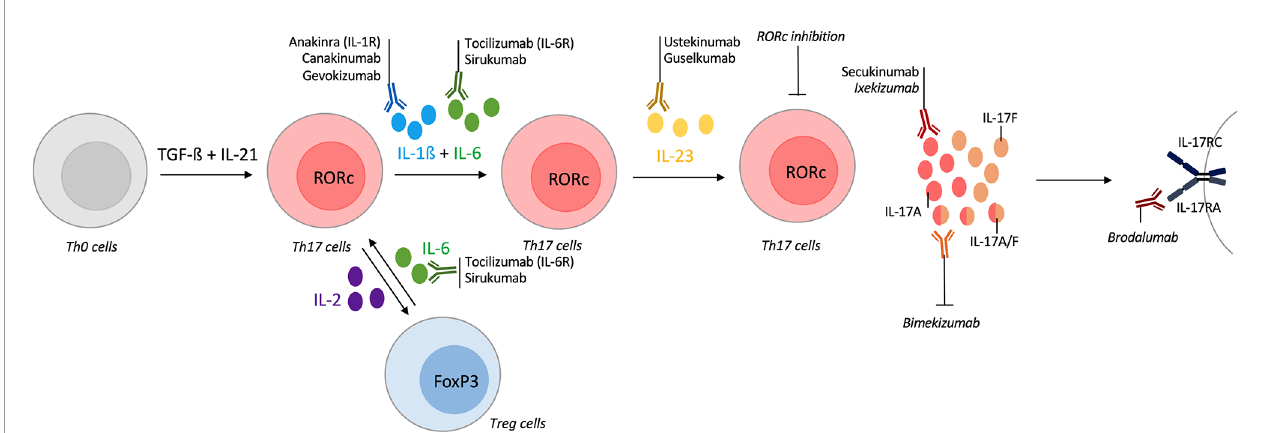
FIGURE 4 | Tools for targeting the IL-17/Th17 pathway in vasculitis. T-helper (Th) 17 differentiation is a multi-step process with different cytokines involved. Their inhibitions could act on Th17 differentiation and modify the course of vasculitis. The fi rst step of Th17 differentiation is mediated by interleukin (IL)-1ß and IL-6. Inhibitors of IL-1ß (canakinumab, gevokizumab) or IL-1 receptor antagonist (anakinra) are available and some were tested in vasculitis. Inhibitors of IL-6 (sirukumab) or of its receptor (tocilizumab) were approved in selected giant-cell arteritis (GCA) patients. IL-6 inhibition also acts on the Th17/regulatory T cells (Treg) dysregulation that occurs in vasculitis. Another way to modulate the Th17/Treg balance is to use low-dose of IL-2. Receptor-related orphan receptor (RORc) inhibition also suppresses Th17 lineage. Then, IL-23 is required for Th17 differentiation and ustekinumab is an inhibitor of the IL-12/IL-23 axis, guselkumab speci fi cally targets IL-23. Promising results in Behc ̧ et disease (BD) are described. After their differentiation, Th17 cells produce IL-17A which could be inhibited by secukinumab or ixekizumab. Bispeci fi c antibodies against IL-17A/IL-17F are currently developing with bimekizumab. brodalumab is an IL-17 receptor antagonist. All biologics targeting directly the IL-17 pathway are represented but secukinumab was the only one tested in